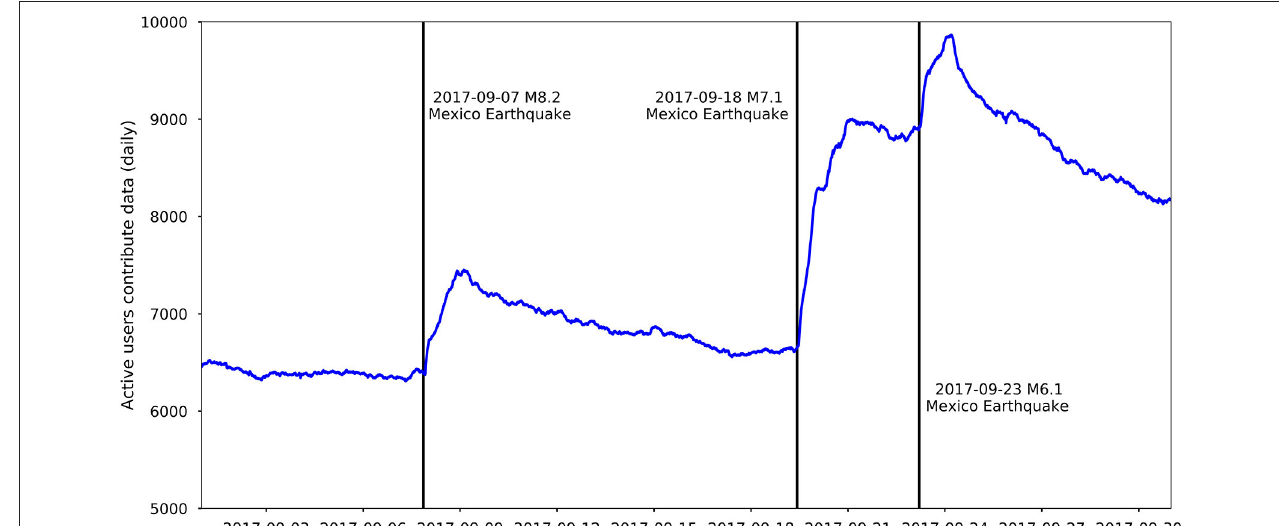
FIGURE 4 | The changes of the active users that contribute data during the Mexico